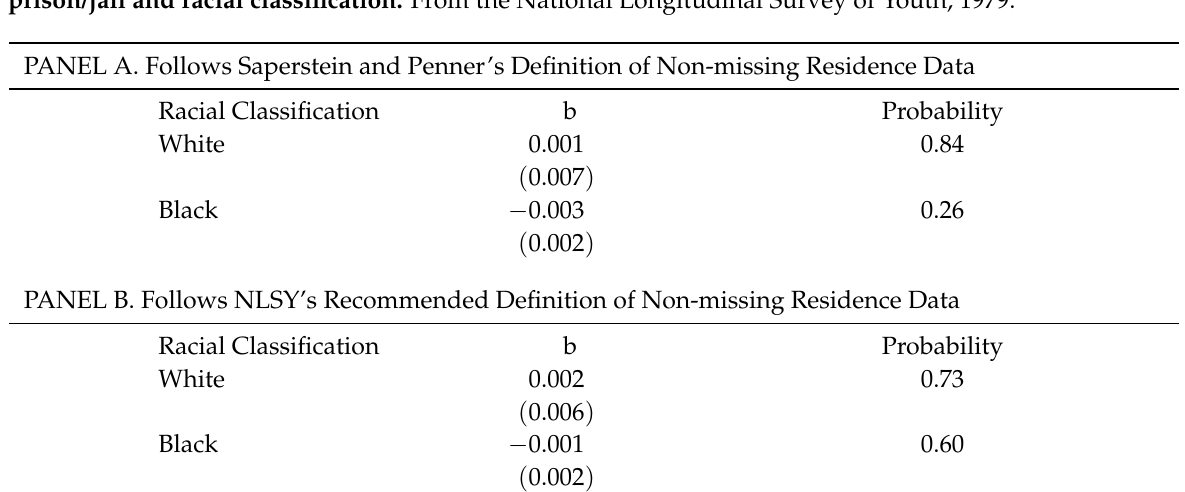
Table 4: Fixed effects linear probability estimates for the relationship between being interviewed in prison/jail and racial classification. From the National Longitudinal Survey of Youth,